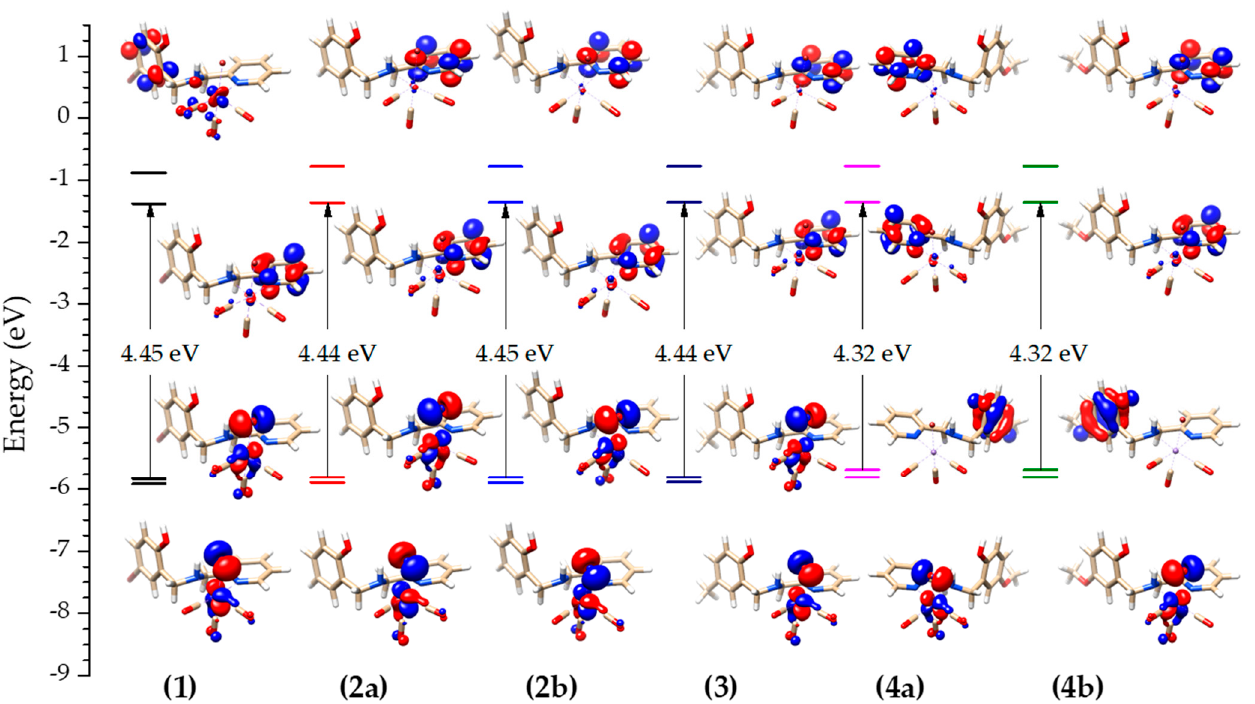
Figure 6. Molecular orbital diagram with the obtained frontier orbitals for all compounds at level B3LYP/def2-TZVP for Mn and Br, and B3LYP/def2-TZVP( − f) for the other atoms in Orca software version 5.0.3.